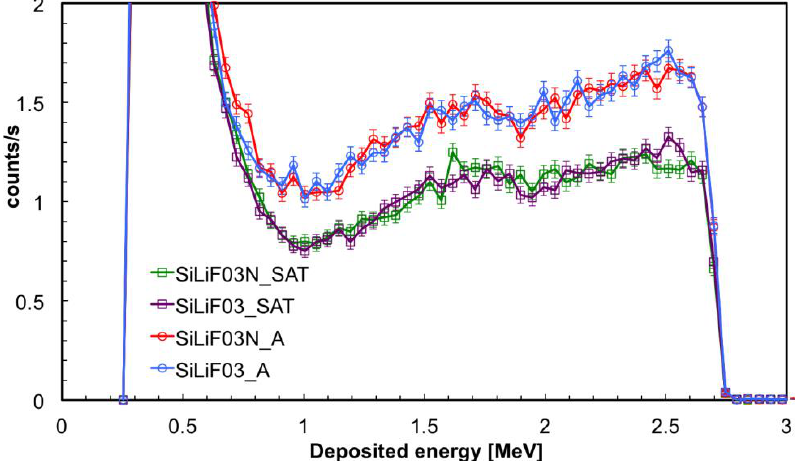
Figure 18. Deposited energy spectra obtained with the detectors SiLiF03 and SiLiF03N, belonging